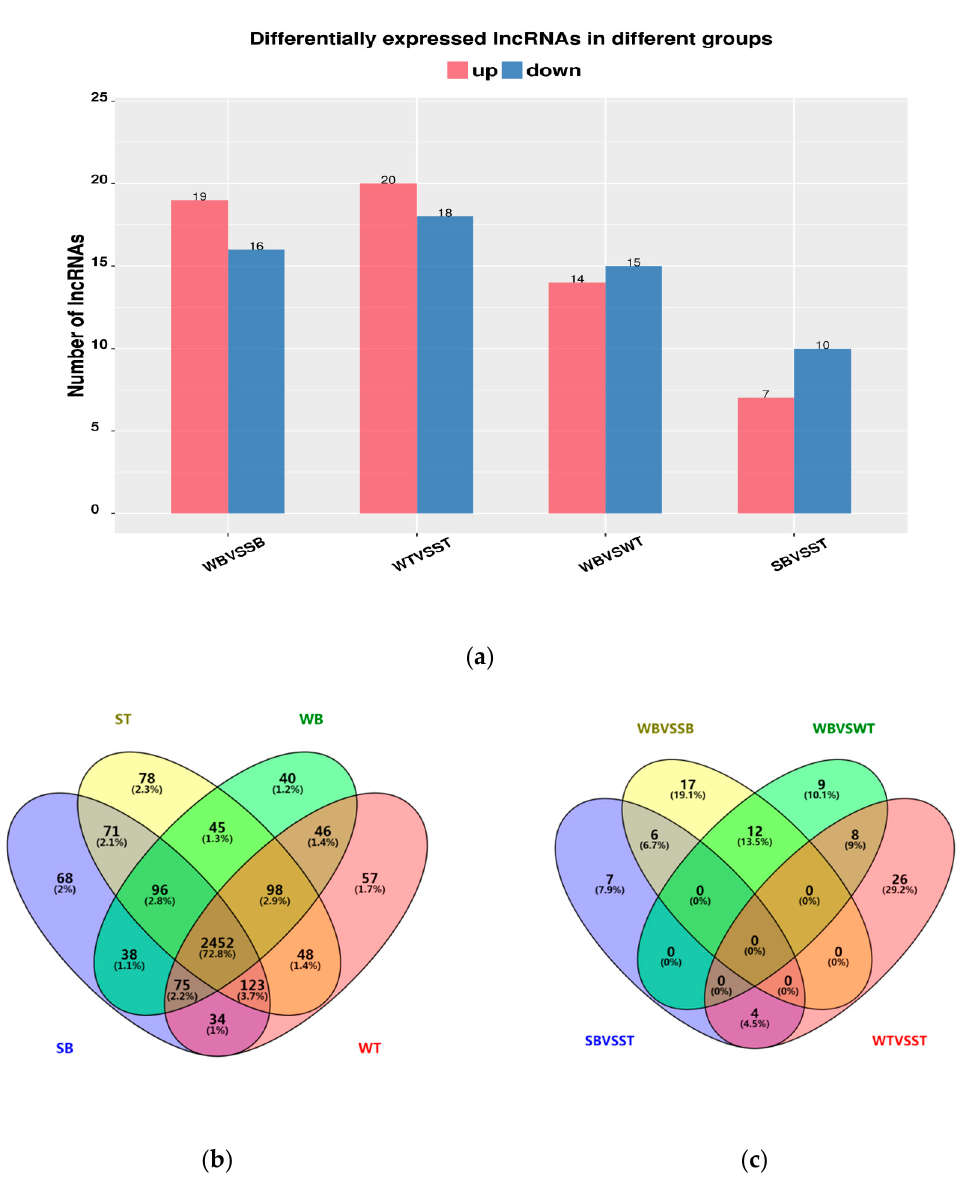
Figure 4. lncRNAs bar chart and venn diagram. ( a ): Differentially expressed lncRNAs in different groups. ( b ): All expressed lncRNAs venn diagram among the four groups. ( c ): Differentially expressed lncRNAs venn diagram among the four groups (WB vs SB, WT vs ST, WB vs WT, SB vs ST). WB, WT, SB, and ST represent WuTou donkey longissimus dorsi muscle, WuTou donkey gluteus muscle, SanFen donkey longissimus dorsi muscle, and SanFen donkey gluteus muscle, respectively.